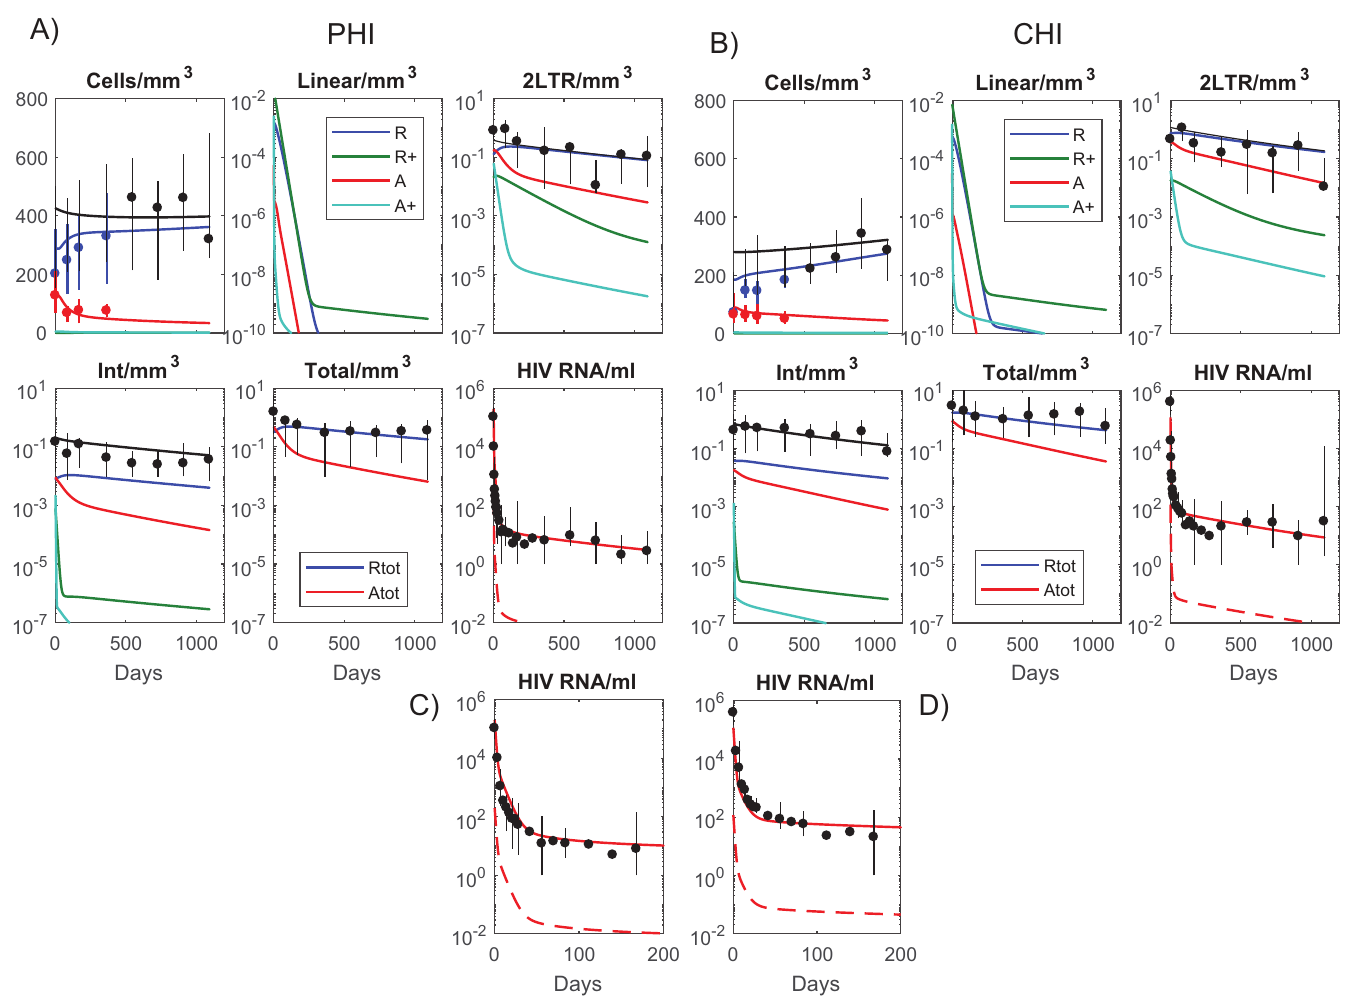
Fig 3. Data (means/medians over the individuals within the PHI and CHI groups, S2 Table)and model simulations for: A) and C) PHI, B) and D) CHI. Vertical lines at data points denote rangeswithin each group. For A) and B) total memory CD4+ T cells/mm 3 , linear HIV DNA/mm 3 , and 2-LTR HIV DNA/ mm 3 are shown as black lines whilecomponentswithin each cell phenotypeare shown as colored lines. Cells/mm 3 are describedon a linear scale while all other panels are shown with a logarithmicy-scale. The colored lines in each of the cellularand HIV DNA panels represent values in the resting/activated, dividing/nondividing subsets as depictedby the legendin the linear HIV DNA panel. The colored lines in the integrated HIV DNA panelsdepict the replicationcompetent subsets. The phenotypes are resting ( R ), resting and dividing( R + ), activated ( A ), and activated and dividing( A + ). In the Total HIV DNA panels each of the resting phenotypes are combined(Rtot) as well as each activated phenotype(Atot). PanelsC) and D) show mean log 10 HIV RNA copies/ml for PHI and CHI over the first 200 days—dashed lines denotethe infectiouscomponentsof pVL.